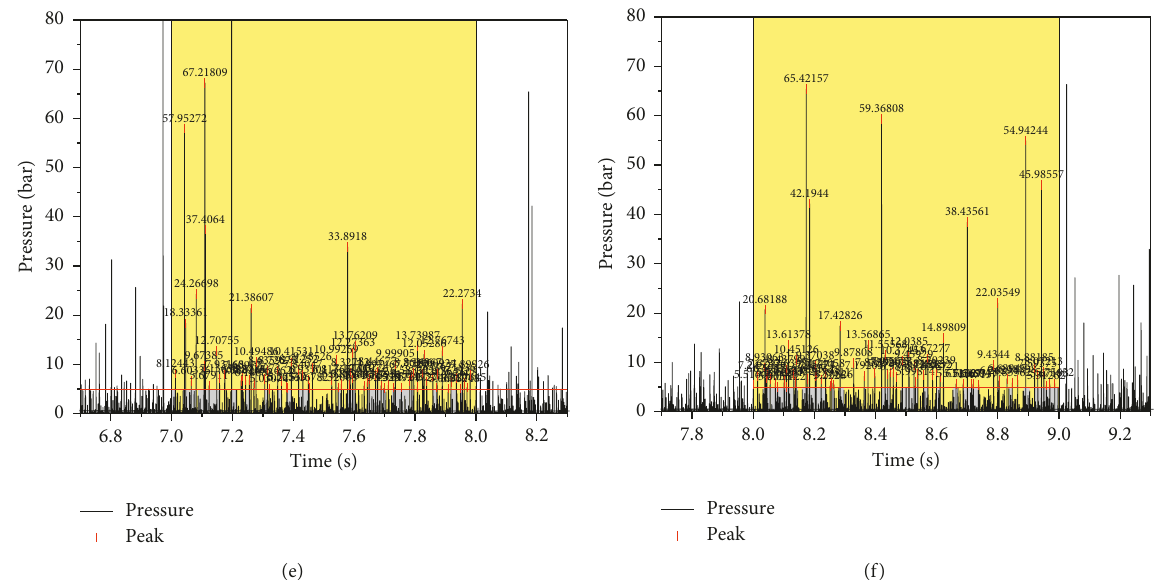
4.5 m 3 /h. (b) Found (cid:31) 8.1m 3 /h. (f) Found 70 (cid:31)